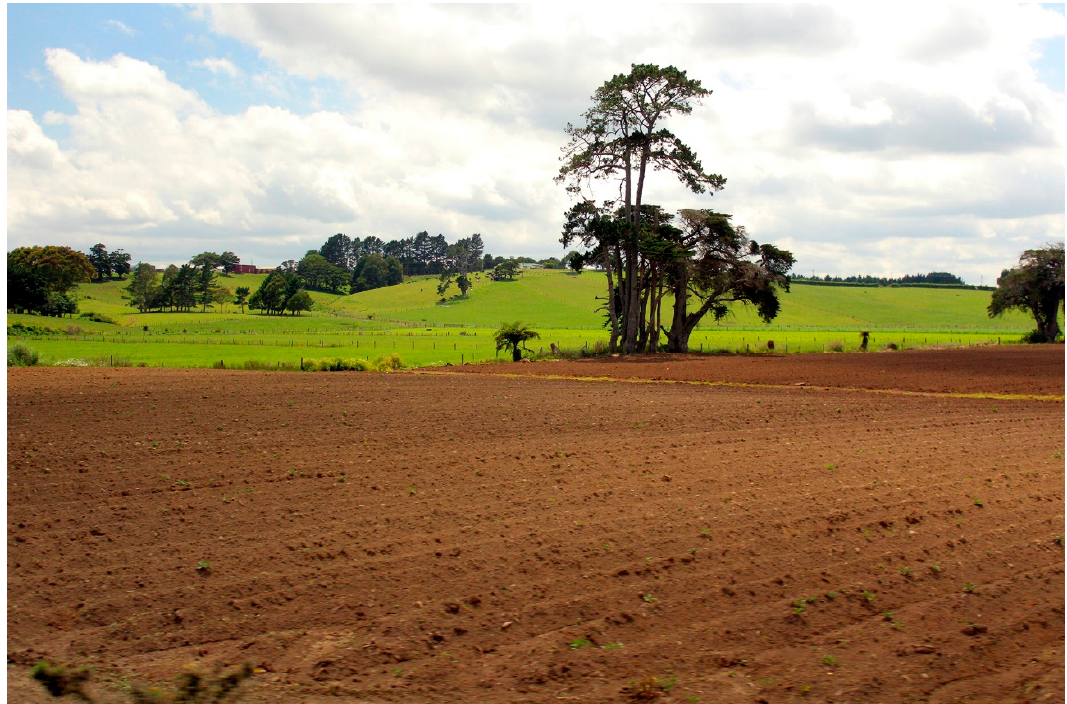
Figure 8. Agricultural lands between Auckland and Pukekohe (Author’s photo, November 2017).